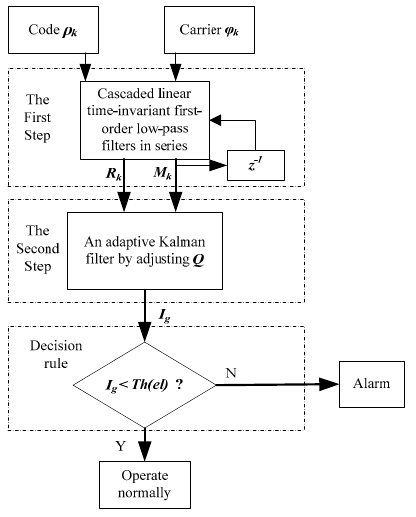
Figure 2. Schematic of proposed TSA ionospheric gradient detection.